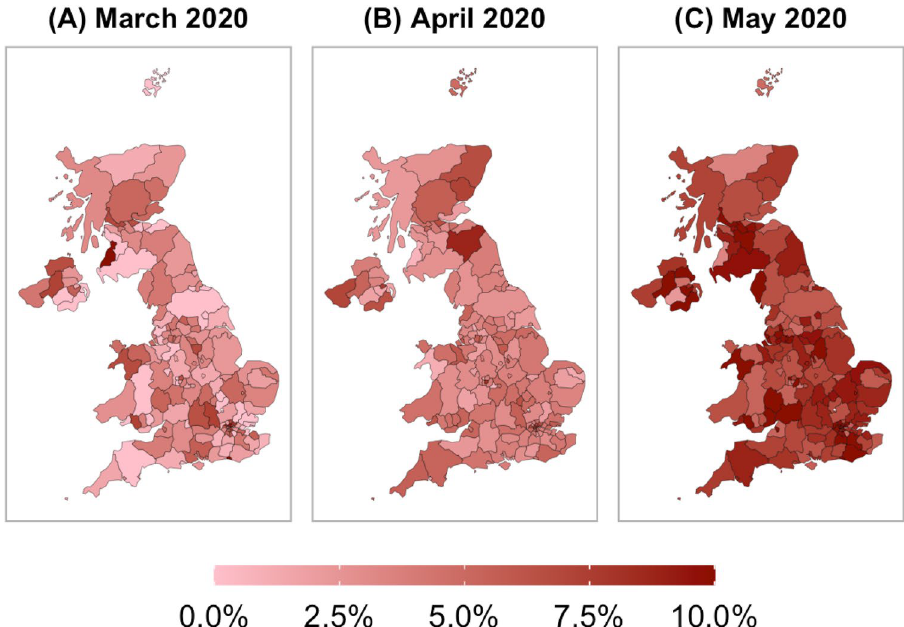
Figure 4. The share of non-compliance varied across regions and over. The panels show the share of non- compliers for each NUTS3 region for different months. In general, non-compliance was the highest in May ( C ) and the lowest in March ( A ), although regional variation exists in all months. Due to these large variations of non-compliance and weather indicators across regions, the inclusion of geographical fixed effects was important to condition on region-specific unobservables. Sample weights are applied. N = 105,512. The maps were created with the programming language R 26